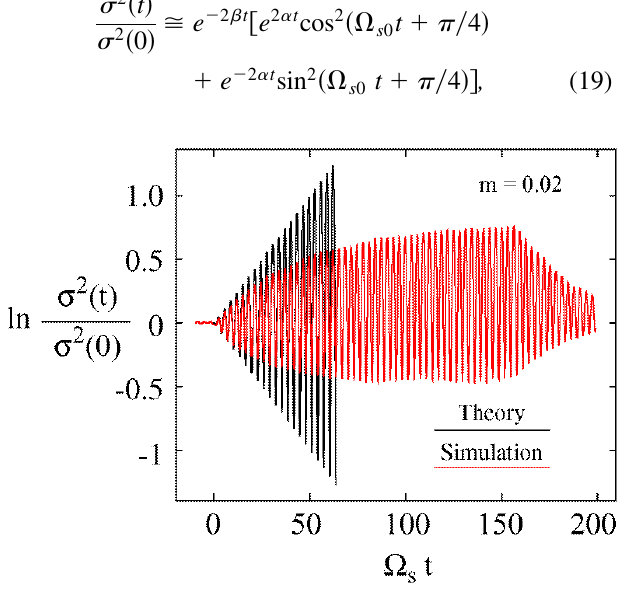
FIG. 8. (Color) Extended simulation result showing nonexpo- nential